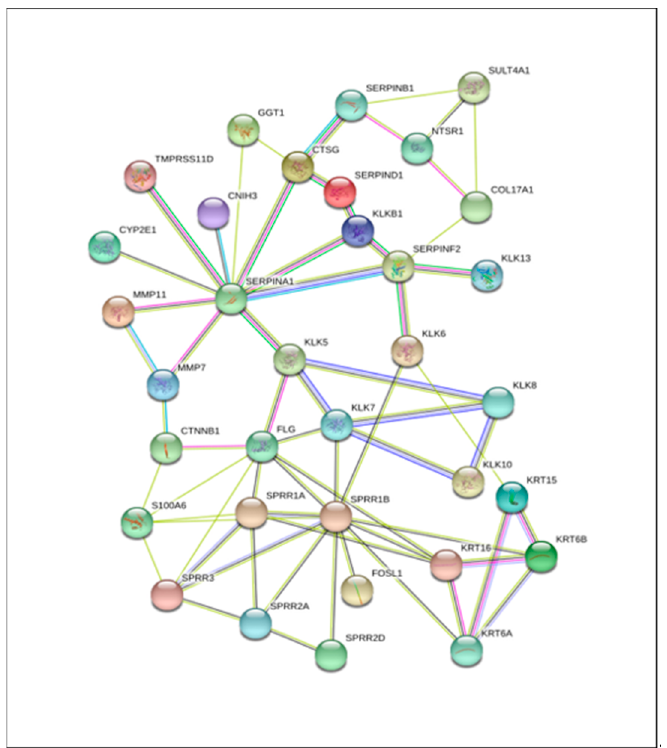
Figure 4. Analysis of Gene Ontology (GO) and signaling pathways associated with KLK6 overexpression in TCGA colon adenocarcinoma samples. Analysis of DEGs for GO shows ( A ) Biological processes. ( B ) Cellular Components and ( C ) Molecular Functional gene sets that are significantly enriched in high expressing KLK6 group. ( D ) Reactome pathways that are enriched in DEGs.